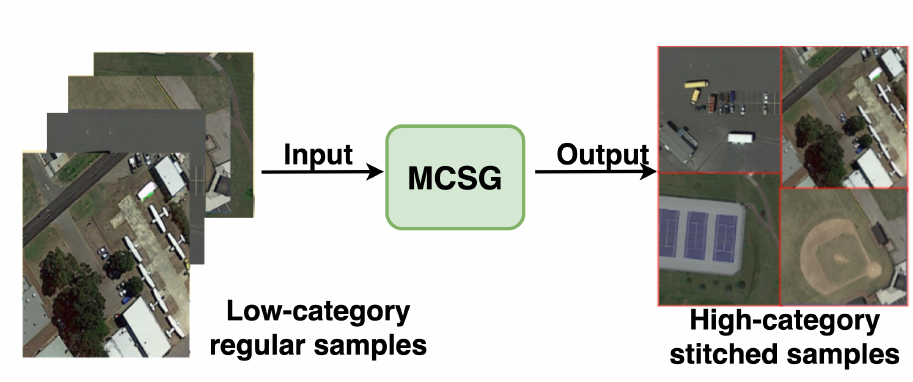
Figure 6. The schematic diagram of MCSG. The low-category samples are stitched in a random scale, random crop, and random arrangement in order to produce more high-category